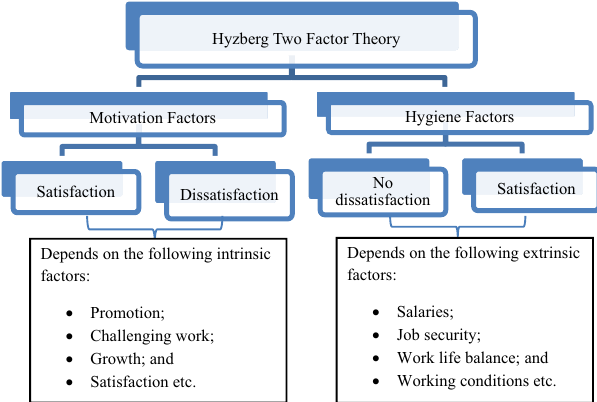
Figure 1. Factors